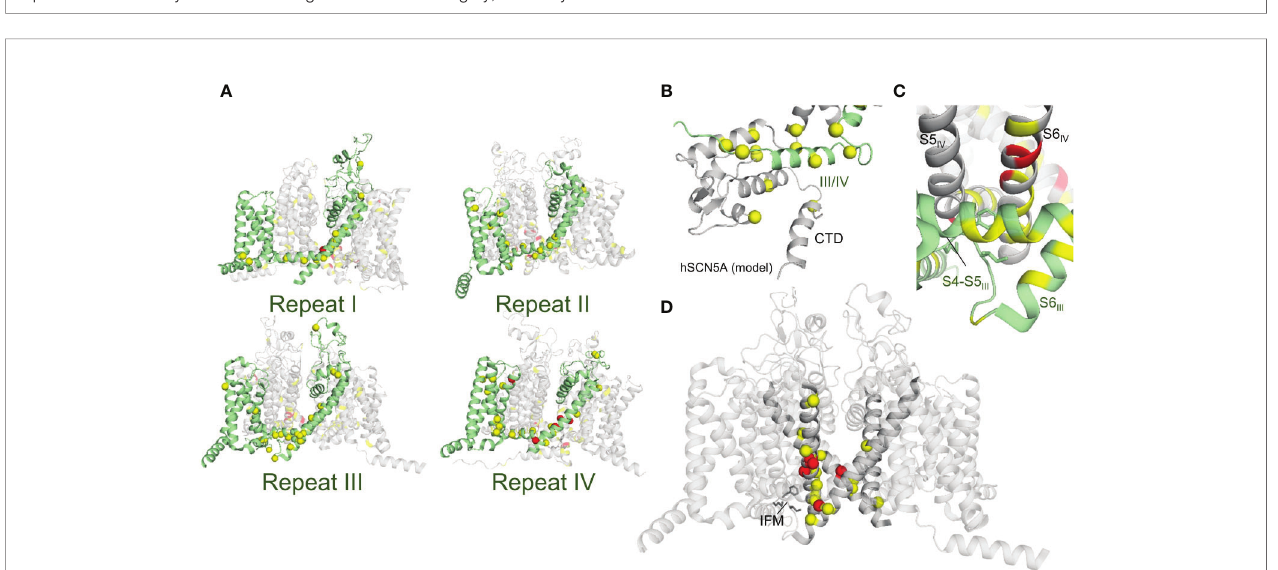
FIGURE 11 | Rat SCN5A structure with deleterious mutation sites indicated. (A) Full SCN5A structure (PDB: 6UZ3) (Jiang et al., 2020). Yellow sites denote locations of a single deleterious mutation, while red indicates sites with multiple mutations identi fi ed. Spheres indicate C-alpha positions of mutation sites. Side views of individual repeats are shown with 90° rotations between panels. In each panel, one repeat is colored green and LQT3 mutation sites for that repeat are mapped. (B) C-terminal domain with bound III/IV linker (human SCN5A model: [(Kroncke Bm, 2019)]. (C) Putative inactivation gate. IFM motif is indicated with sticks. (D) SCN5A constriction site. S6 helices are shown at full opacity, with the IFM motif indicated with